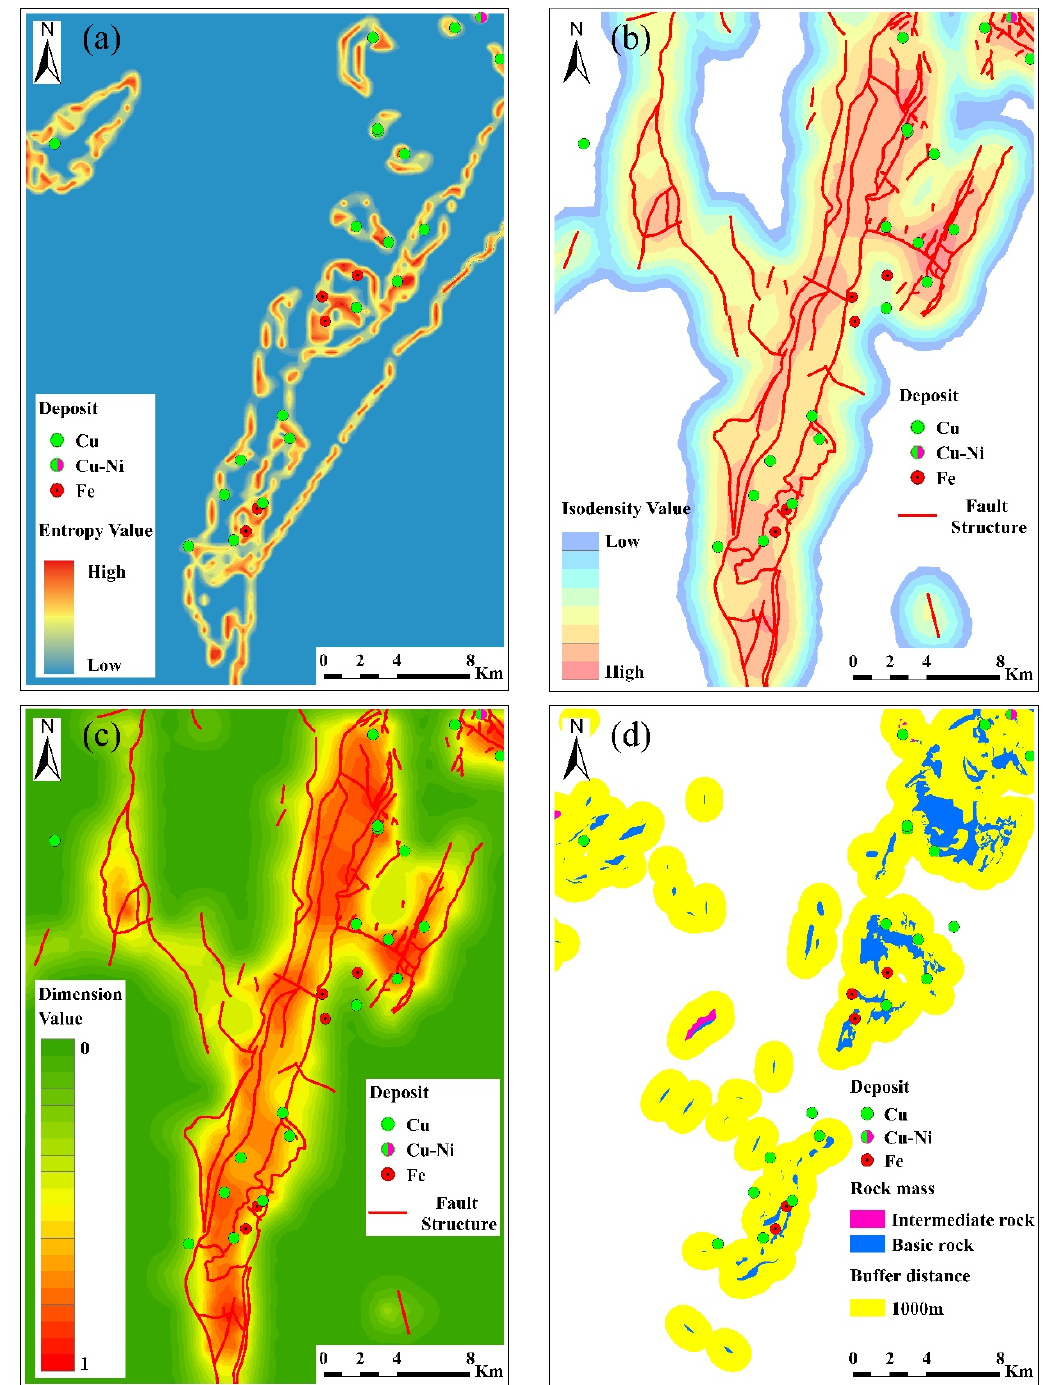
Figure 5. ( a ) Formation combination entropy; ( b ) isodensity map of structural faults; ( c ) dimension value map of structural faults; ( d ) rock mass buffer distribution map.